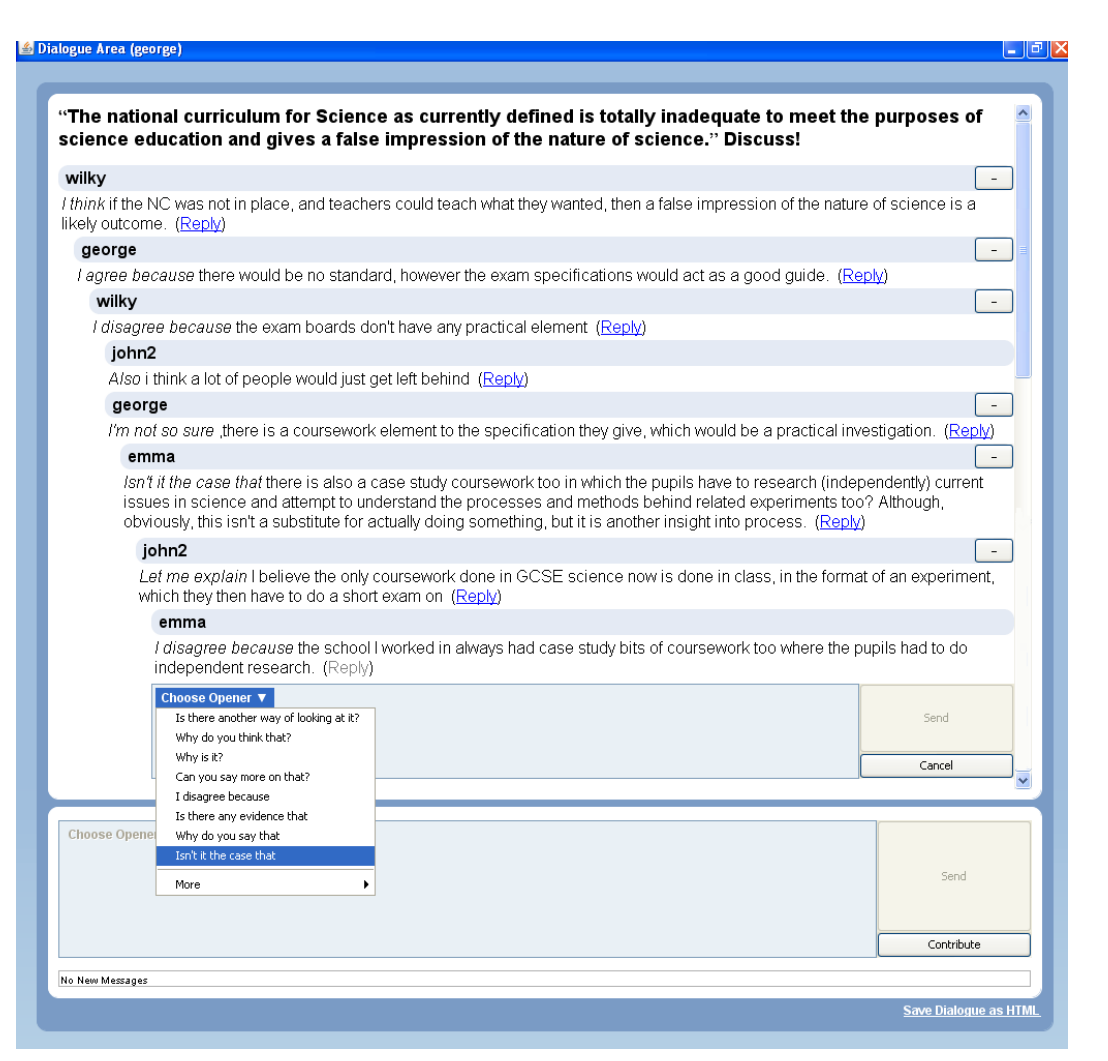
Figure 1 . A critical dialogue demonstrating how connectivist, dialectic, and dialogic features are realised through